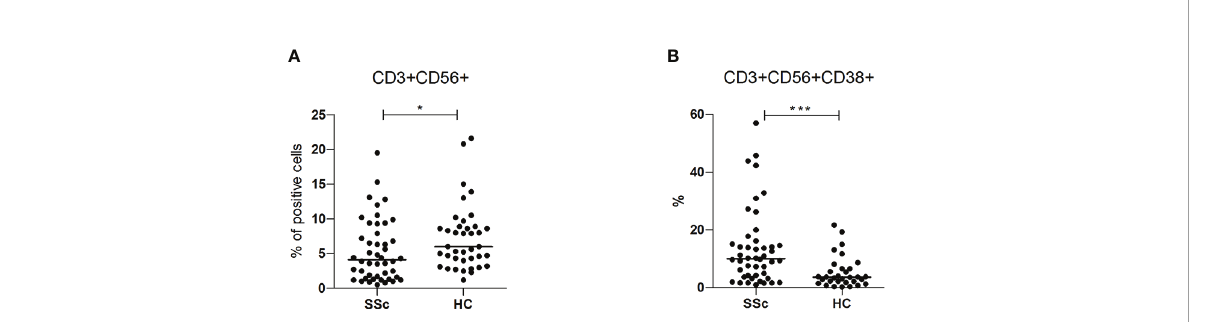
FIGURE 3 (A, B) CD3+CD56+ surface antigen expression of PBMC from SSc patients (SSc; n = 46) and healthy controls (HC; n = 32) and CD3+CD56 +CD38+ surface antigen expression of PBMC from SSc patients (SSc; n = 17) and healthy controls (HC; n = 20) were analyzed by fl ow cytometry. Results are expressed as percentage of positive cells. Horizontal bars represent median values; *= p < 0.05; *** = p < 0.001. Mann- Whitney test was used for inter-groups